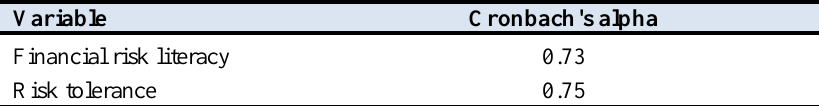
Table 1. The Cronbach's alpha coefficient of the questionnaire Variable